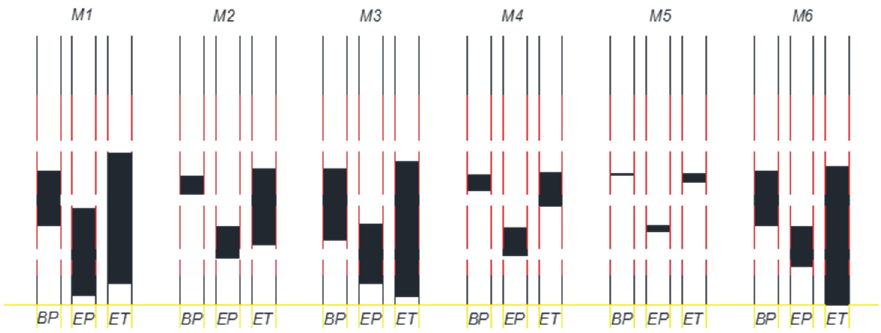
Figure 6. LNAPL thickness (Zo) in monitoring wells at the beginning of pumping (BP), end of pumping (EP), and end of test (ET) for E1.